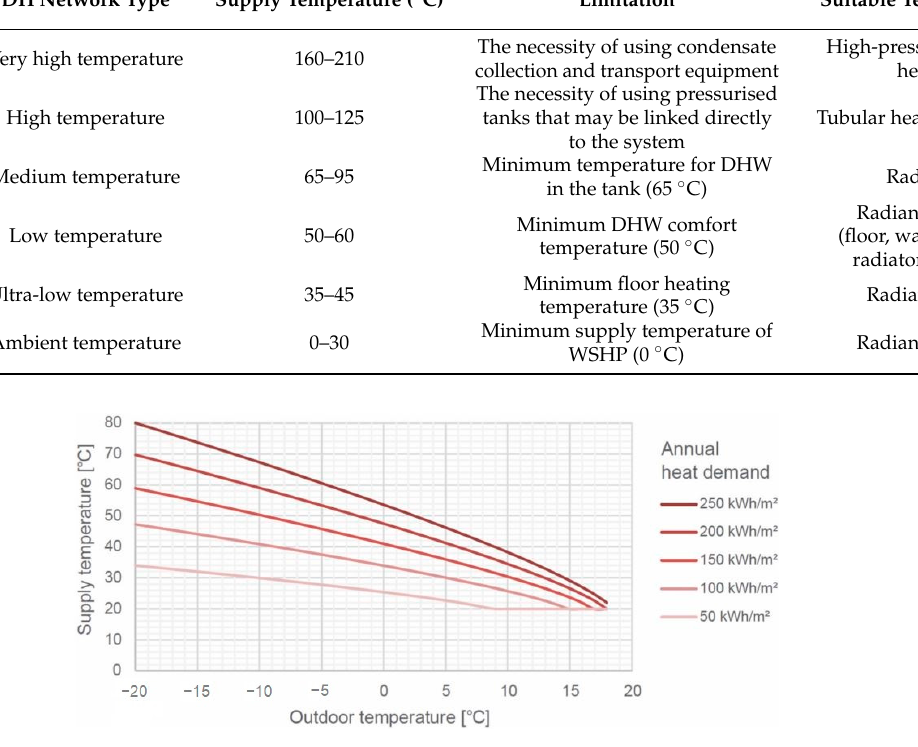
Figure 2. The necessary supply temperatures in a radiator